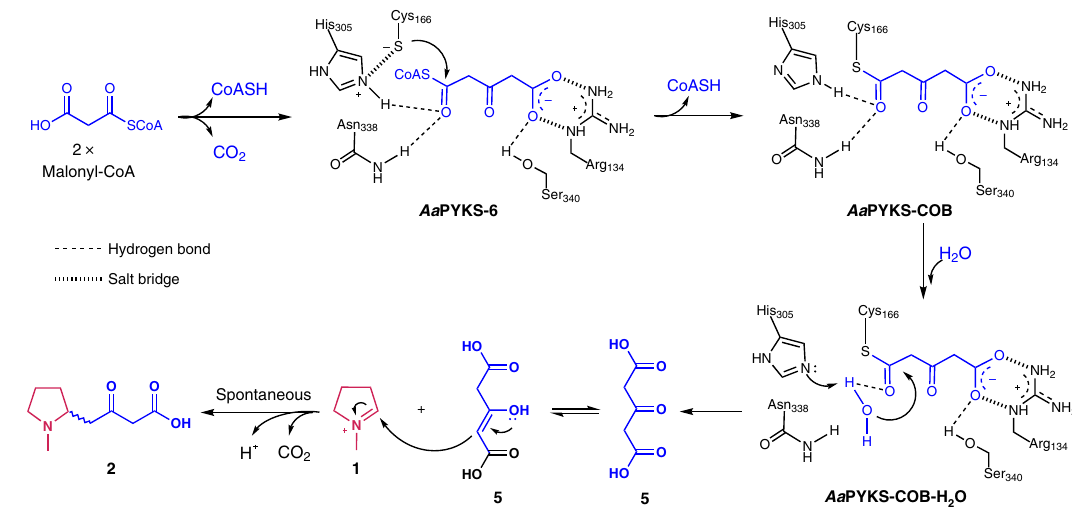
Fig. 4 Proposed mechanism for Aa